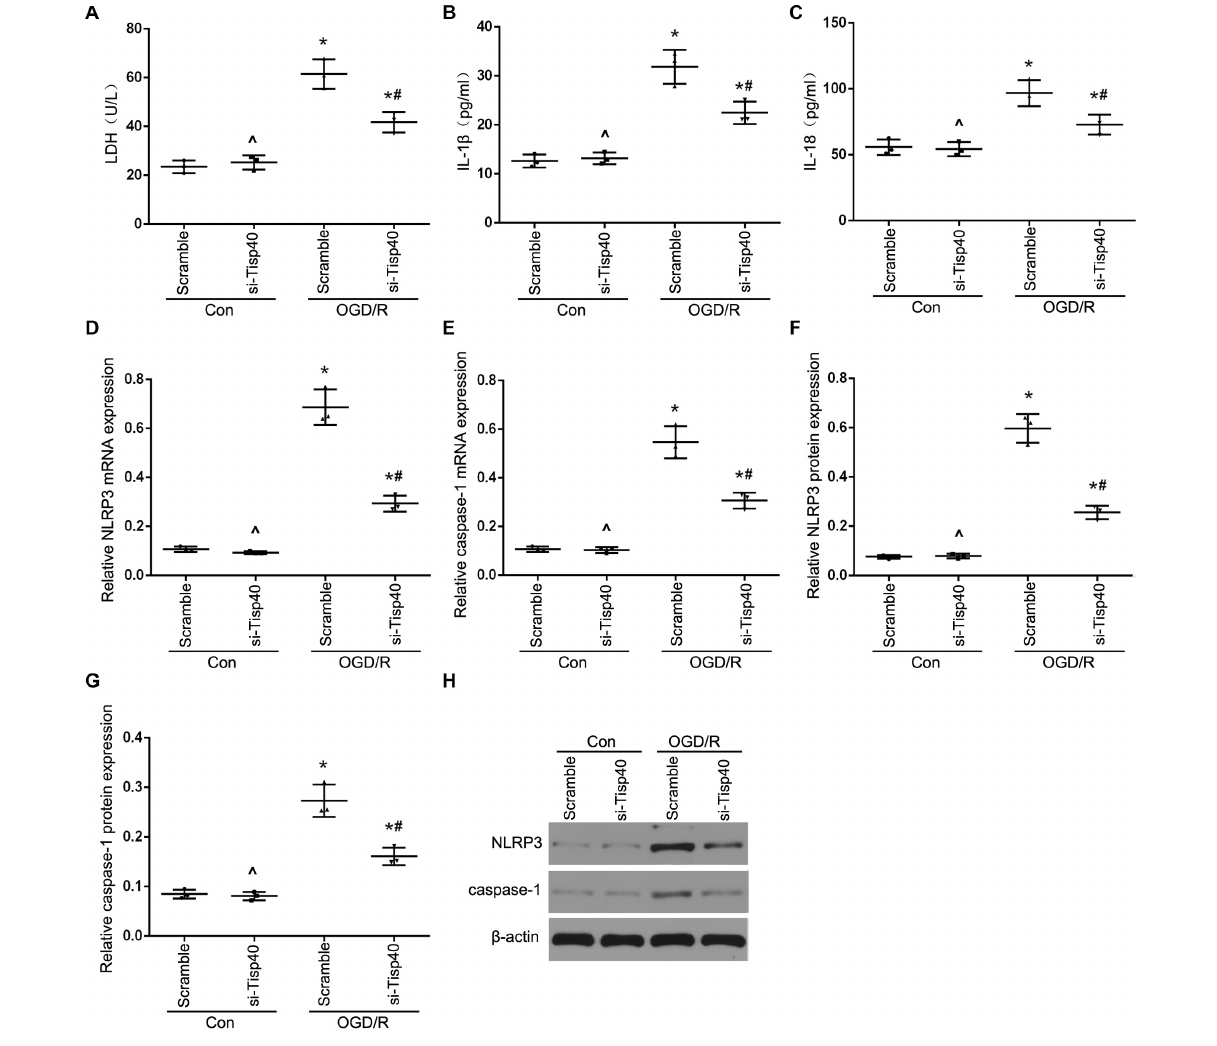
FIGURE 4 | Tisp40 inhibitor alleviated NLRP3 inflammasome activation in cultured OGD/R-stimulated TCMK-1 cells. (A) The LDH release was detected by activity assays. IL-1 β (B) and IL-18 (C) contents were measured by using ELISA kits. (D–H) The expression of NLRP3 and caspase-1 were analyzed by qRT-PCR and western blot. Data are expressed as the mean ± SD. n = 5 per group. * P < 0.05 vs. corresponding control groups (Con). ∧ P > 0.05 vs. scramble con group. # P < 0.05 vs. the group of Scramble induced by OGD/R, one-way